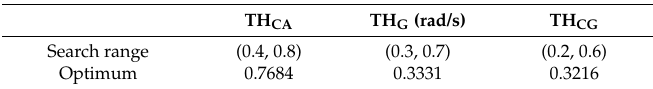
Table 4. Threshold ranges and values of Alg. 3 for the MobiAct dataset.